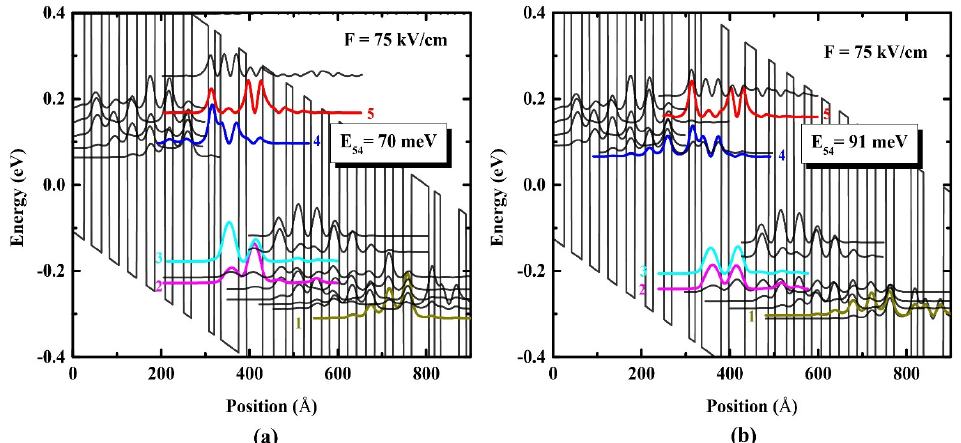
Figure 1. Band diagrams of the referenced ( a ) and modified ( b ) designs at 75 kV/cm electric field. The energy states marked with different colors are the excited state (E 5 ), the upper state (E 4 ), the lower state (E 3 ), the extracted state (E 2 ) and the injected state (E 1 ).